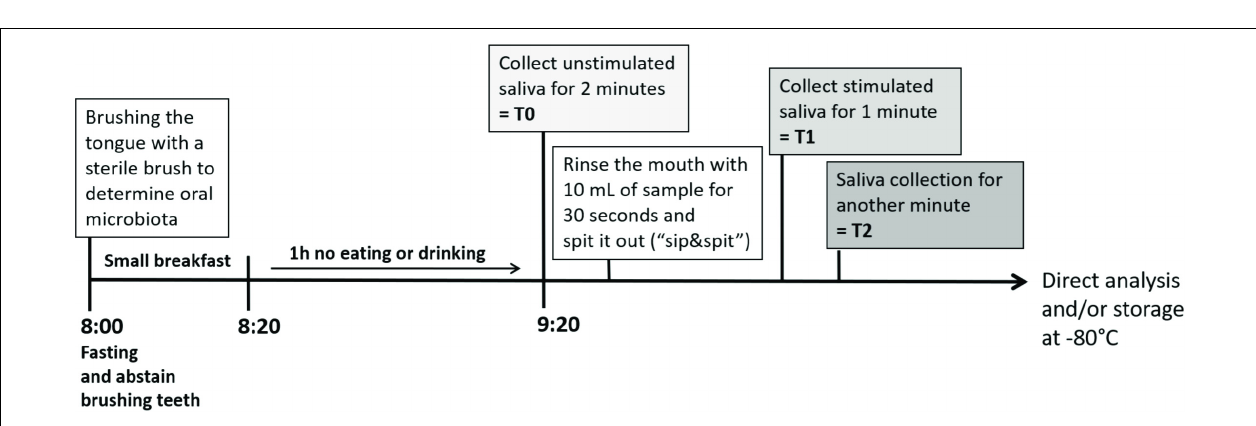
FIGURE 2 | Study design—timeline and overview of a study day with sampling of oral microbiome, unstimulated (T0) and stimulated saliva in the first (T1) and second (T2) min after stimulation with one of the test compounds. The procedure was repeated for each test compound on a separate day with at least 3 days apart.